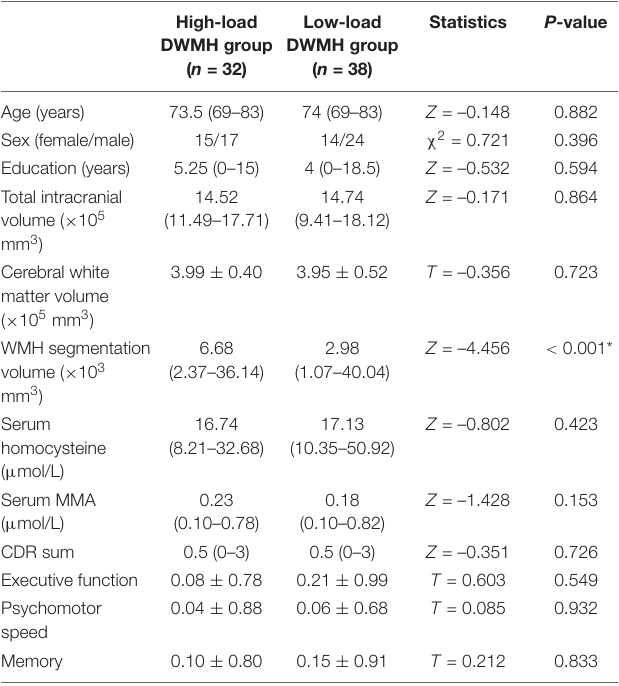
TABLE 1 | Comparison of demographic data between the high-load and low-load deep white matter hyperintensity (DWMH)